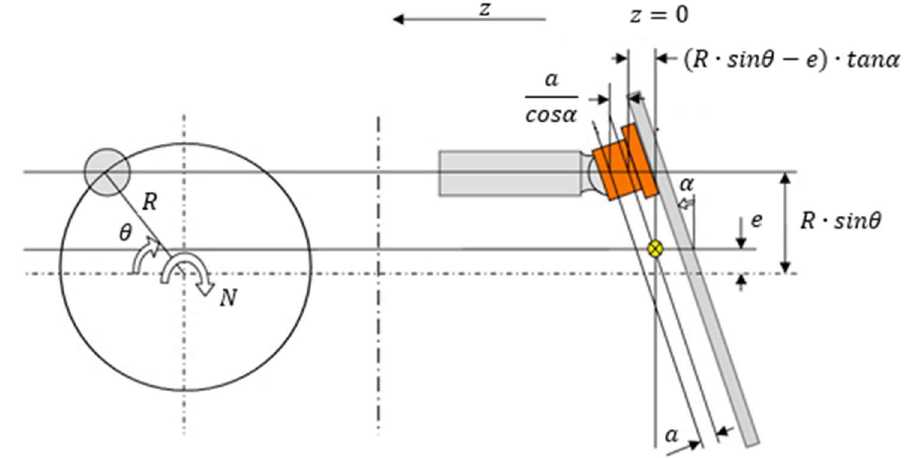
Figure 4. Geometrical scheme for the kinematic model.